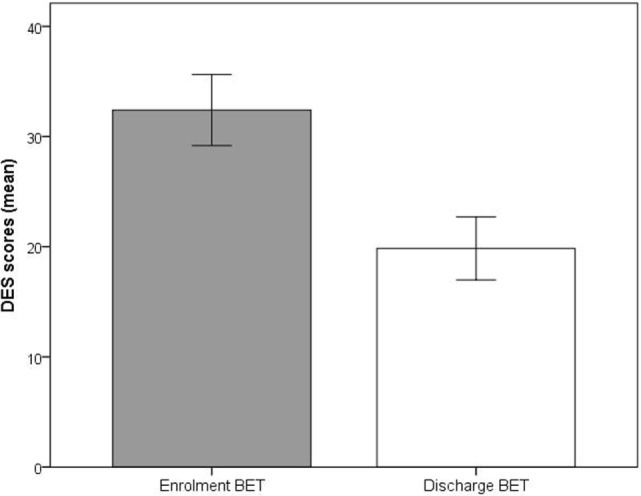
Changes in Dissociation Experience Scale from enrollment to discharge. Lines are SEs.